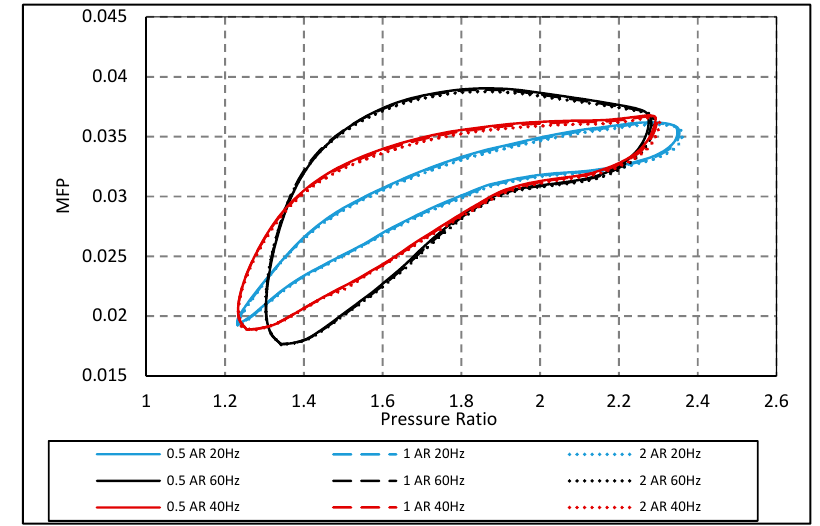
Figure 12. MFP vs. pressure ratio for each of the volute aspect ratio designs with modified A/r distributions.